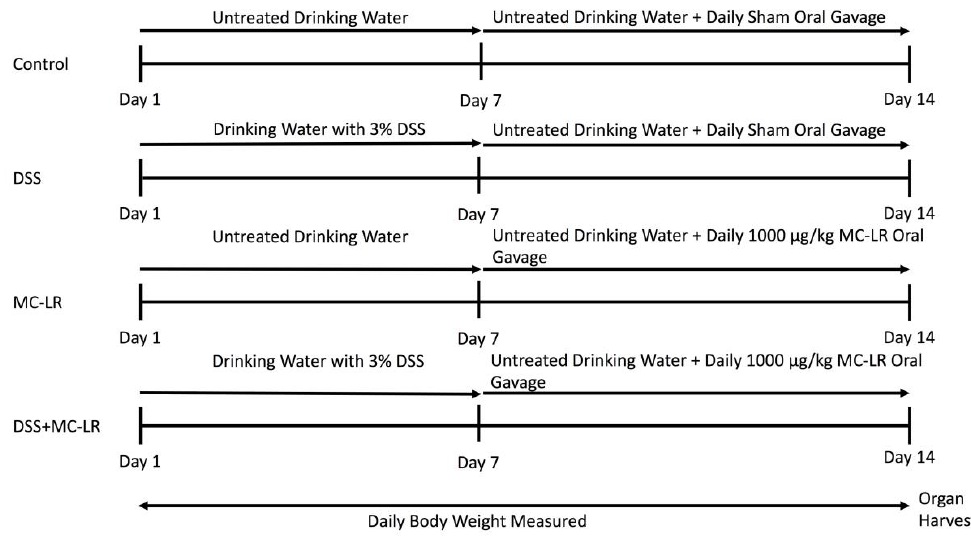
Figure 10. Experimental design evaluating the effects of DSS exposure, MC-LR exposure, and DSS + MC-LR exposure in the colons of C57BL/6 mice and CD40KO mice.